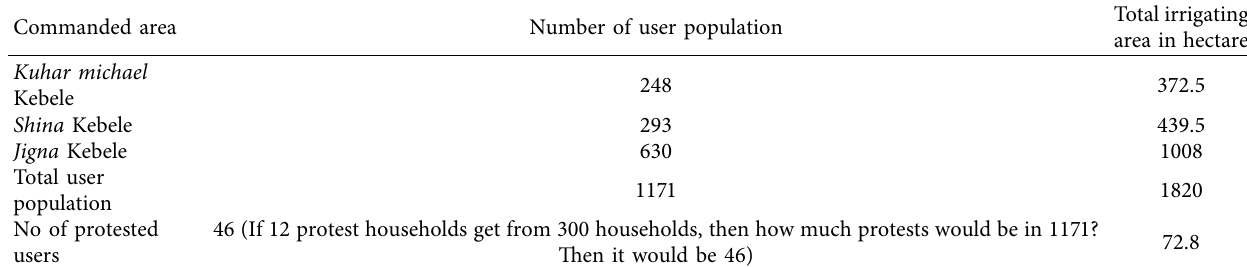
Table 9: Estimation of aggregate willingness to pay.